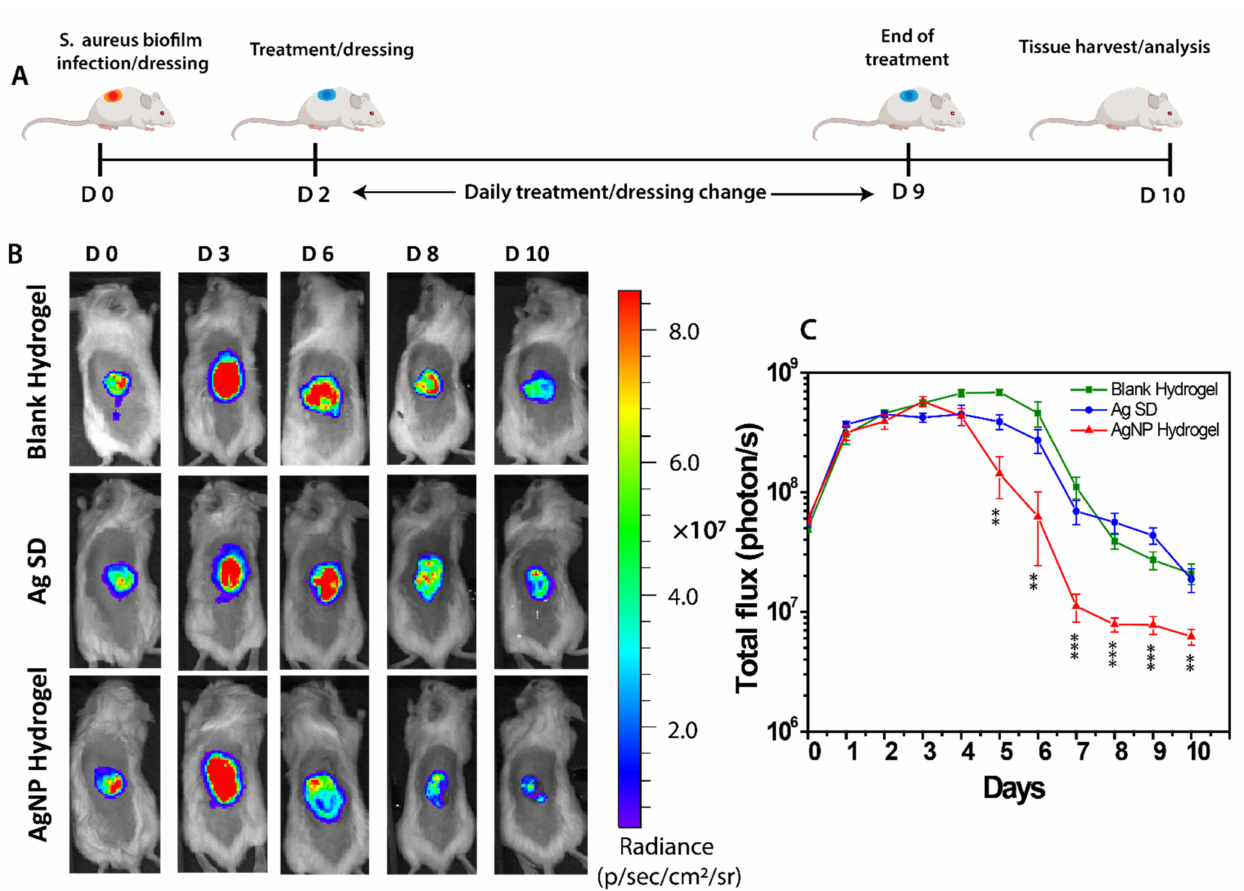
Figure 4. In vivo therapeutic effect of AgNP hydrogel against mature S. aureus biofilms. ( A ) Schematic illustration of study progression. ( B ) Representative photographs of IVIS bioluminescent signal differences between treatment groups. ( C ) Average bioluminescent signals corresponding to bacterial burden expressed as the average total flux (photons/s) over 10 days of treatment. Data are shown as mean ± SEM and the * denotes significant difference compared to blank hydrogel using Student’s t -test ** p < 0.01, and *** p < 0.001. n =